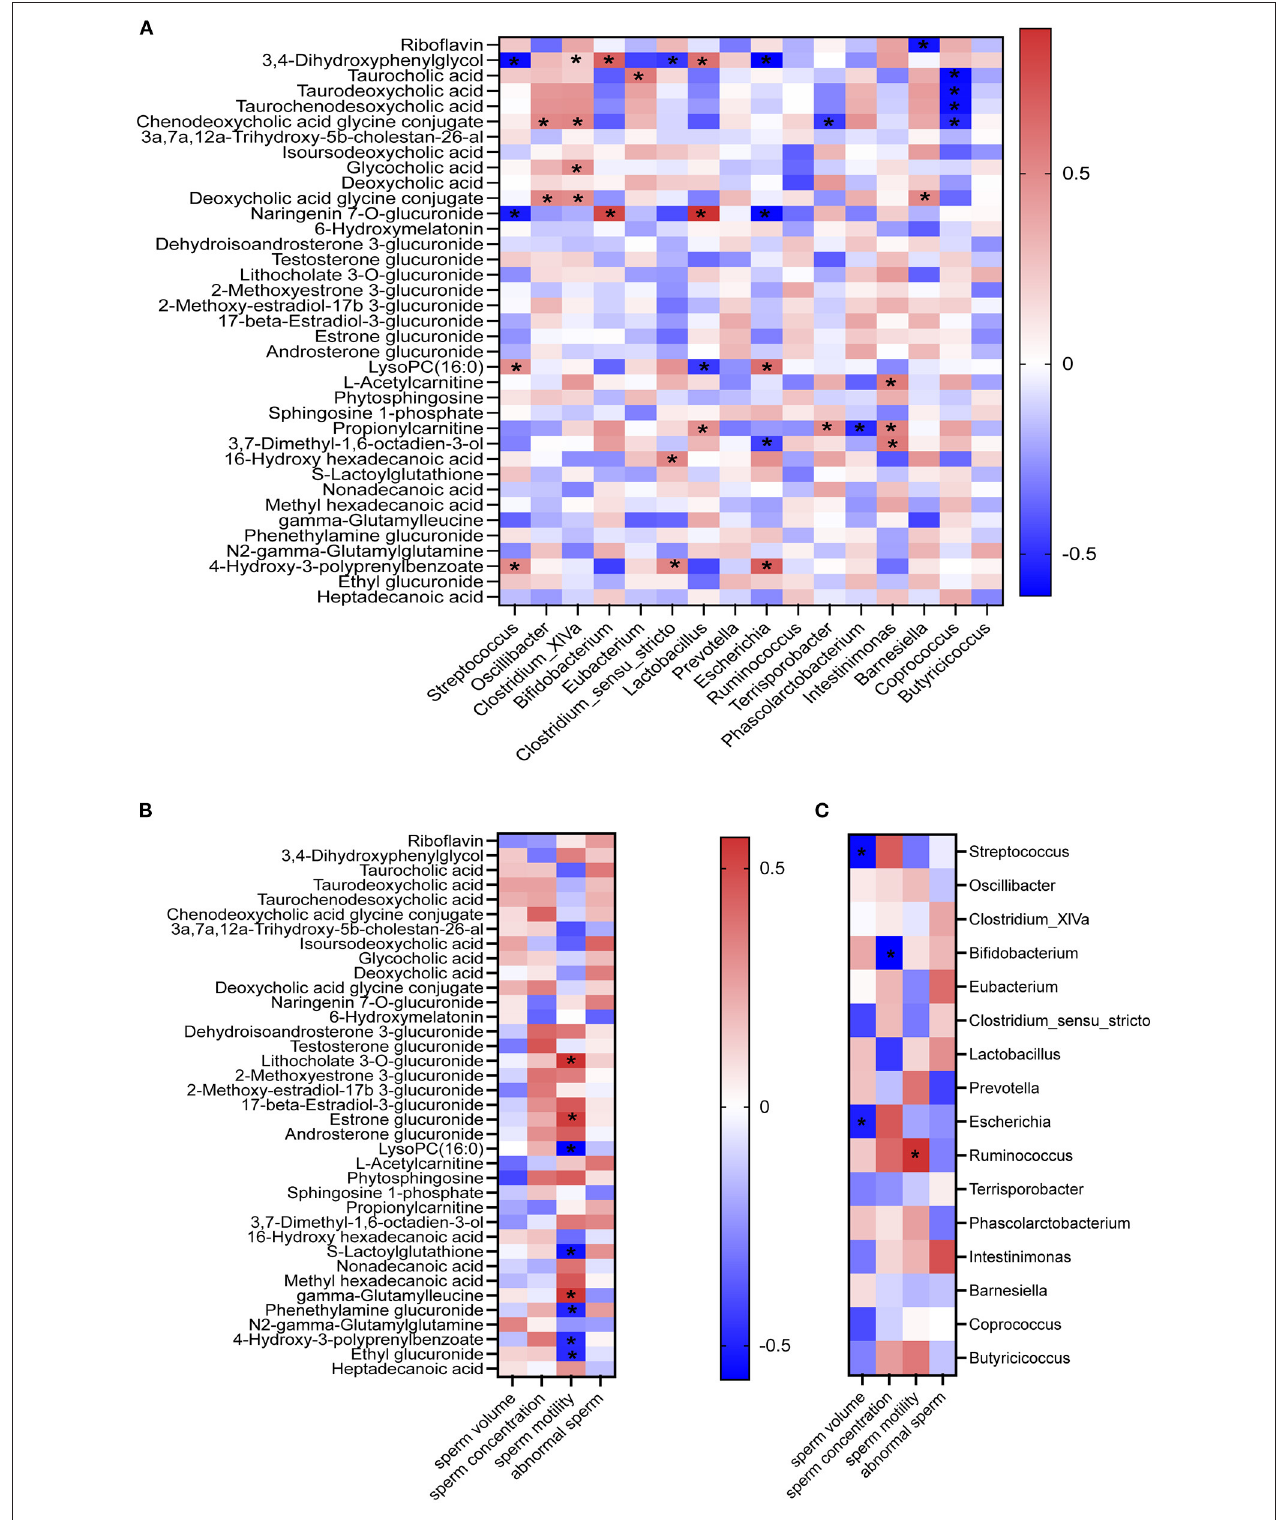
FIGURE 5 | Correlations. Correlations between fecal microbiota and plasma metabolites (A) ; between plasma metabolites and semen quality parameters (B) ; and between fecal microbiota and semen quality parameters (C) by Pearson correlation analyses. * P < 0.05.